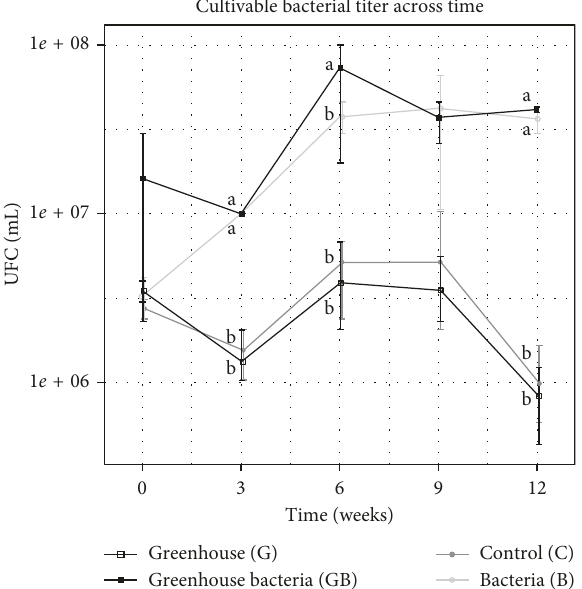
Figure 2: Cultivable bacterial titers per treatment across time. Means within a time measured followed by the same letter are not significantly different according to the Tukey–Kramer test or Nemenyi test in case of no